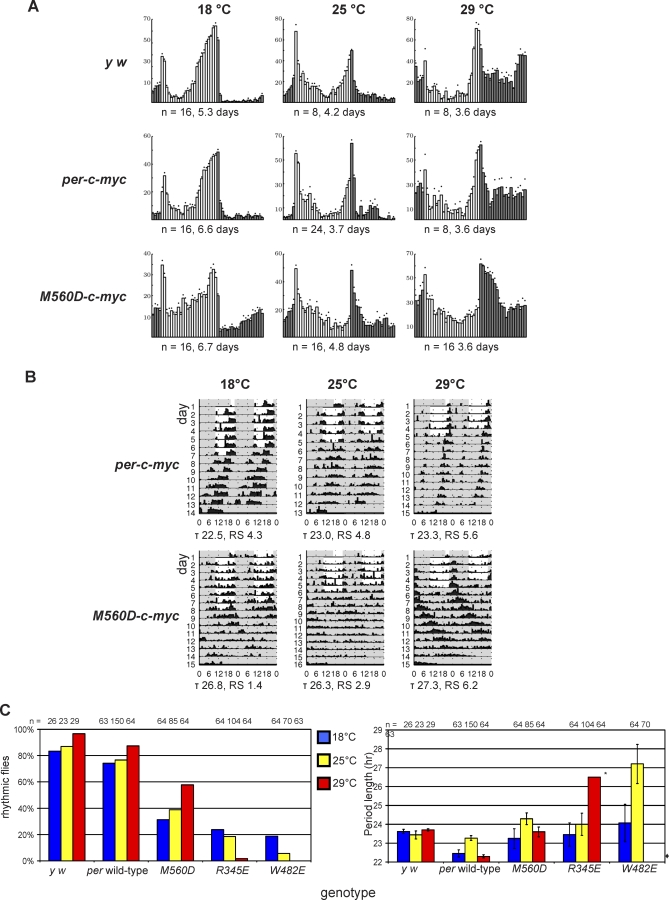
PER:PER Dimer Formation Is Important for Normal Locomotor RhythmsLocomotor rhythms of nontransgenic per+ control flies (y w), per01 flies carrying the wild-type PER encoding transgene, or the M560D encoding transgene (both fused to either HA or c-MYC). Flies were kept for 4–7 d in LD followed an additional week in DD at the temperatures indicated above each panel.(A) Daily average plots of control and mutant flies for the LD portion of the experiment. Note that M560D mutants show less robust anticipation of the LD and DL transitions, but are still able to shift their activity to the light or dark portion in cold and warm temperatures, respectively. For per-c-myc data from 4 transgenic lines were pooled (2-2-1, 2-2-2, 2–3, and 2–6). For M560D-c-myc data from lines 10-2-1 and 10-2-2 were pooled.(B) Individual actograms of the LD and DD part of the experiment showing control (line 2–6) and mutant flies (line 10-2-2). For the M560D mutant long-period rhythmic individuals were selected to demonstrate that the period remains almost constant at the different temperatures (i.e., normal temperature compensation). Similar results as shown in (A) and (B) were obtained with the respective HA-tagged lines or lines expressing both transgenic types (unpublished data, [C] and Table S1).(C) Quantification of DD behavior in control and mutant M560D, R345E, and W482E flies. Shown are averages of all transgenic lines analyzed (Table S1). M560D mutants show a drastic reduction of rhythmicity compared to controls, whereas the other mutants are almost completely arrhythmic (left panel). Temperature compensation is normal in controls and M560D mutants but impaired in the few rhythmic individuals of the other 2 mutants. *, only one rhythmic fly; ♦, all flies were arrhythmic; n, the number of animals included in the calculation.